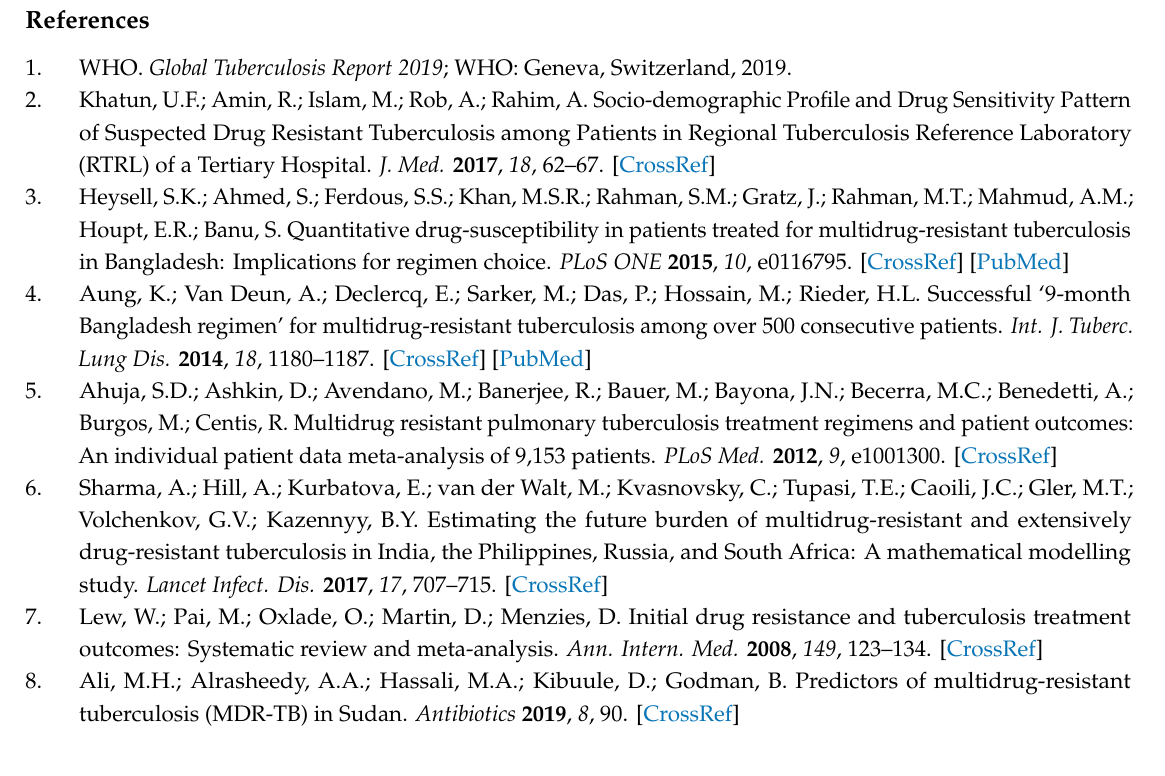
Table S1: Search strategy, Table S2: Quality assessment of the included cross-sectional studies, Table S3: Quality assessment of the included cohort studies, Figure S1: Any resistance to first- and second-lines anti-TB drugs: (A) streptomycin, (B) isoniazid, (C) rifampicin, (D) ethambutol, (E) pyrazinamide, (F) kanamycin, (G) amikacin, (H) gatifloxacin, (I) ofloxacin, (J) moxifloxacin, (K) ethionamide, (L) prothionamide, (M) cycloserine, (N) para-aminosalicylic acid, and (O) levofloxacin, Figure S2: Mono resistance to anti-TB drugs: (A) streptomycin, (B) isoniazid, (C) rifampicin, (D) ethambutol, and (E) pyrazinamide, Figure S3: Any resistance to anti-TB drugs in newly diagnosed patients: (A) streptomycin (B) isoniazid, (C) rifampicin, (D) ethambutol (E) pyrazinamide, (F) gatifloxacin, (G) kanamycin, (H) levofloxacin, (I) moxifloxacin, (J) ofloxacin resistance and any resistance to anti-TB drugs in previously treated and newly diagnosed patients as well as any resistance to anti-TB drugs in previously treated patients: (K) streptomycin, (L) isoniazid, (M) rifampicin, (N) ethambutol, (O) pyrazinamide, (P) kanamycin, (Q) amikacin, (R) gatifloxacin, (S) ofloxacin, (T) moxifloxacin, (U) ethionamide, (V) prothionamide, (W) cycloserine, (X) para-aminosalicylic acid, and (Y) levofloxacin, Figure S4: Mono resistance to anti-TB drugs in newly diagnosed patients: (A) streptomycin, (B) isoniazid, (C) rifampicin, and (D) ethambutol and mono resistance to anti- TB drugs in previously treated patients: (E) streptomycin, (F) isoniazid, (G) rifampicin, (H) ethambutol, and (I) ofloxacin, Figure S5: Overall DRs in newly diagnosed and previously treated TB patients. (A) Any-DR in newly diagnosed patients, (B) any-DR in previously treated patients, (C) mono-DR in newly diagnosed patients, (D) mono-DR in previously treated patients, (E) multi-DR in newly diagnosed patients, (F) multi-DR in previously treated patients, (G) poly-DR in newly diagnosed patients, and (H) poly-DR in previously treated patients, Figure S6: Sensitivity analyses: excluding low-quality studies from (A) any drug-resistance, (B) multi drug-resistance, (C) extensive drug-resistance; excluding small studies from (D) any drug-resistance, (E) mono drug-resistance, (F) multi drug-resistance, (G) poly drug-resistance, and H) extensive